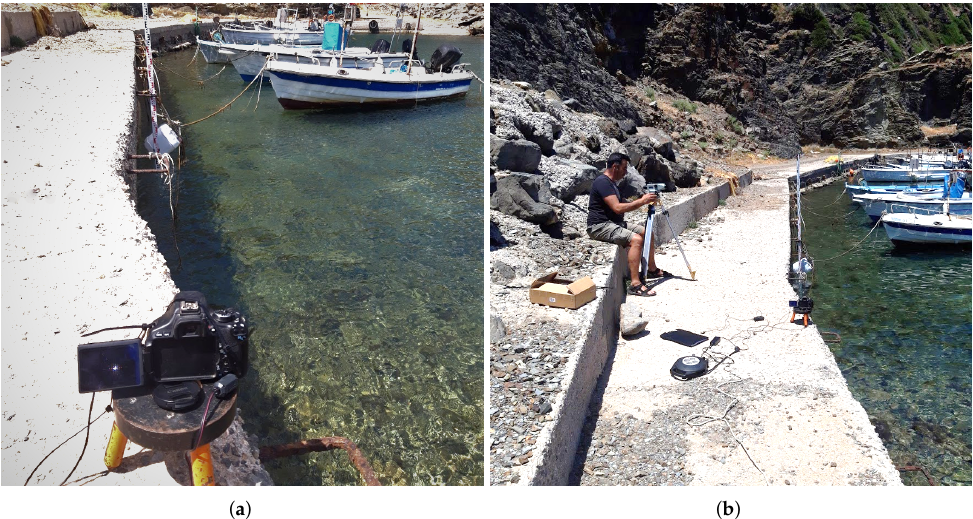
Figure 8. The setting for the execution of the video tide gauge experiment at RDK1 Cal/Val site ( a ) and the levelling survey carried out to tie tide pole measurements with water level measurements determined by tide gauges ( b